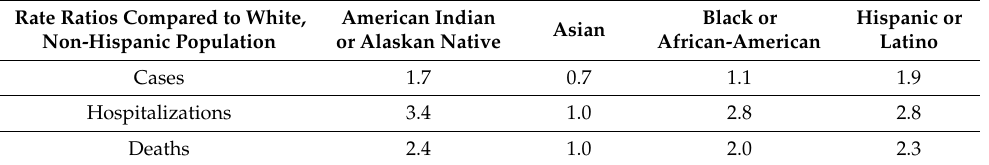
Table 1. Differences with respect to ethnicity between number of cases, hospitalizations, and deaths